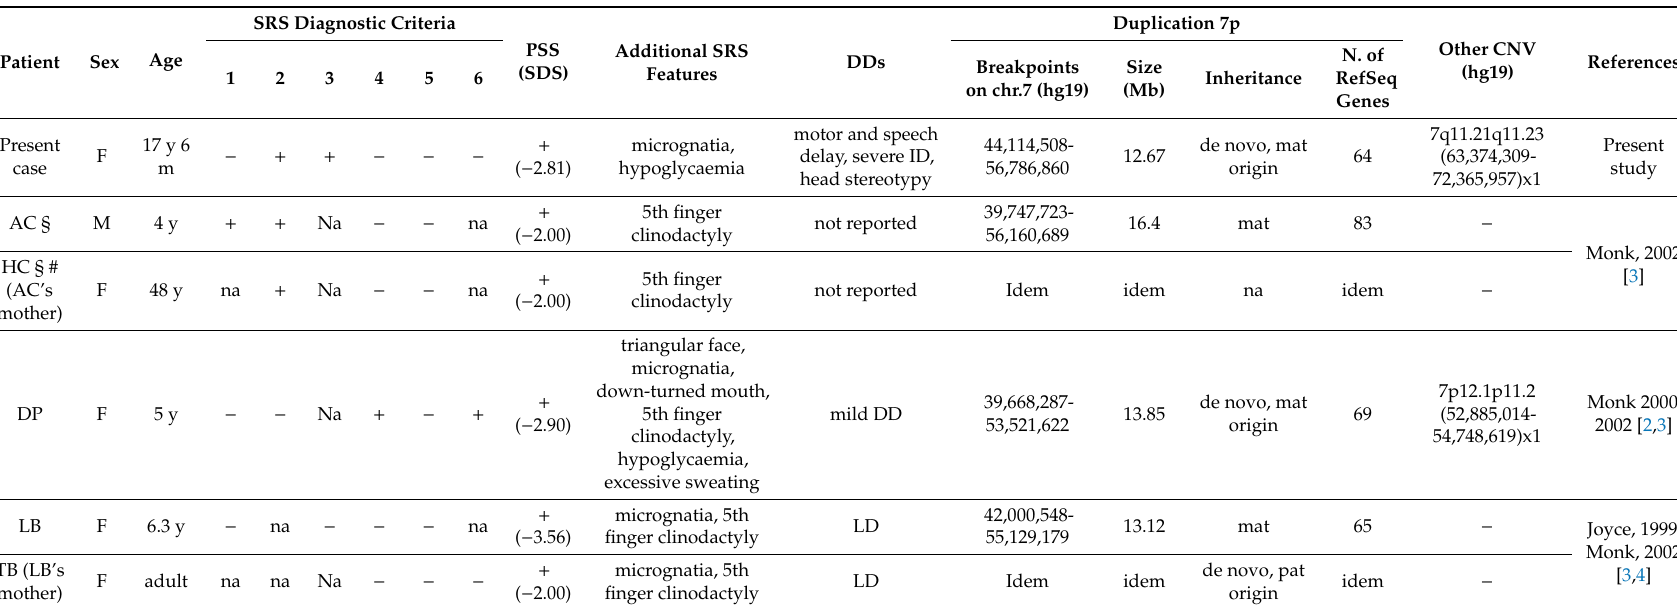
Table 3. Literature review of 7p maternal duplications encompassing the GRB10 gene compared with the present case. SRS: Silver-Russell syndrome; 1, SGA: small for gestational age; 2, postnatal growth failure; 3, relative macrocephaly at birth; 4, protruding forehead; 5, body asymmetry; 6, feeding di ffi culties and / or low BMI (Body Mass Index); PSS, proportionate short stature; DD, developmental delay; ID, Intellectual Disability; LD, learning disability; + , present; − , absent; pat, paternal; mat, maternal; §, mosaic duplication 7p; #, paternal uniparental disomy (UPD) for chromosome 7 in cells with a normal karyotype; y, years; m,